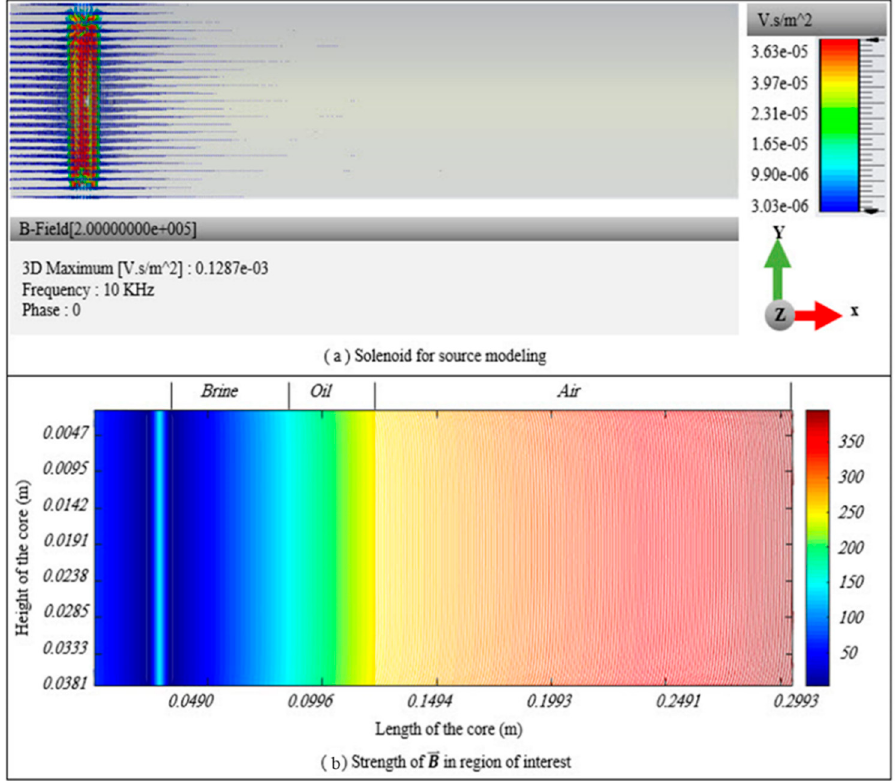
Figure 5. Source modeling and magnetic-field profile during fluid motion in porous medium.